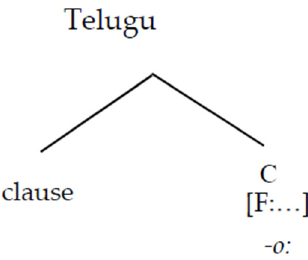
(Åfarli and Subbarao 2019, p. 43)